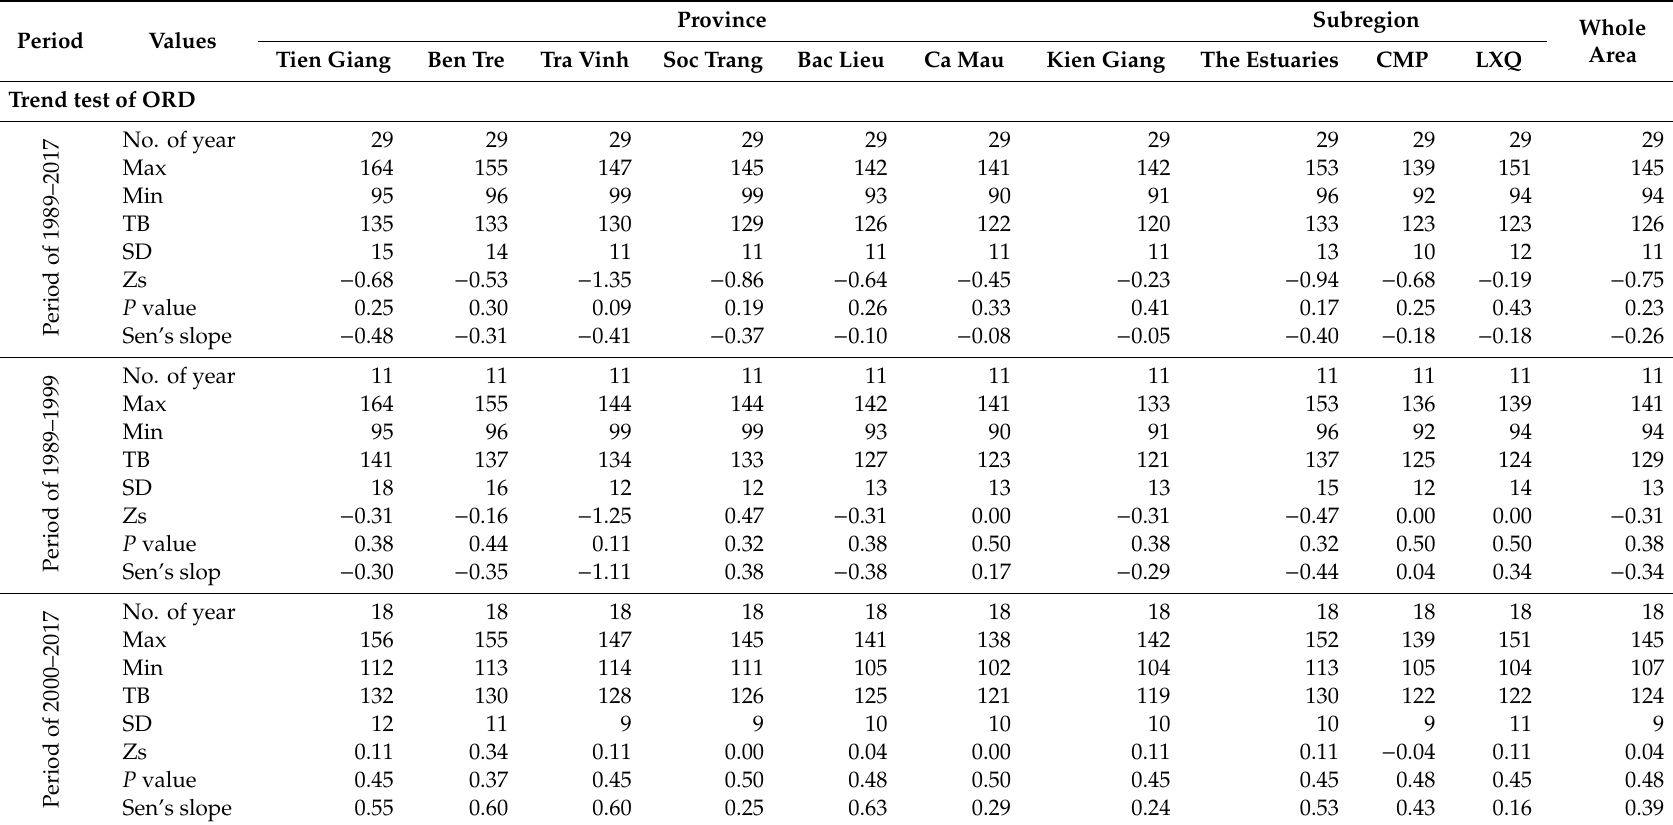
Table A2. Results of trend test of various rainfall characteristics for di ff erent